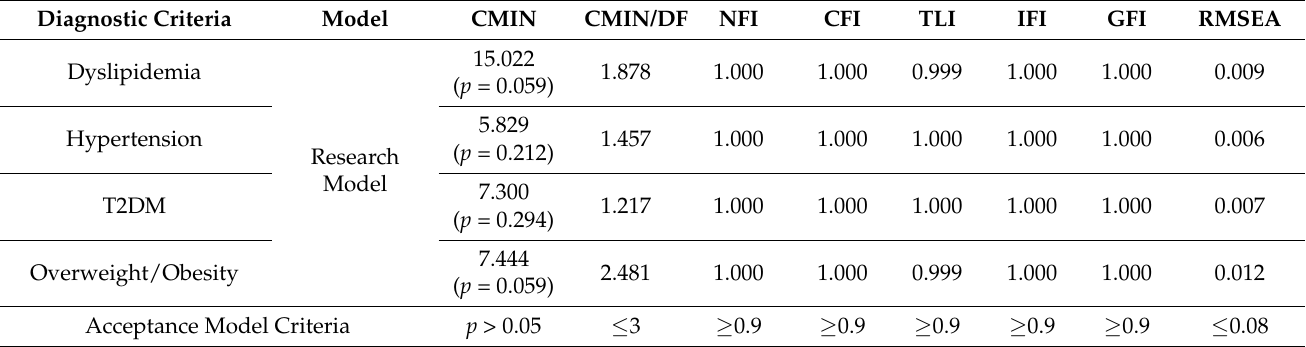
Table 6. Evaluation of the fitted